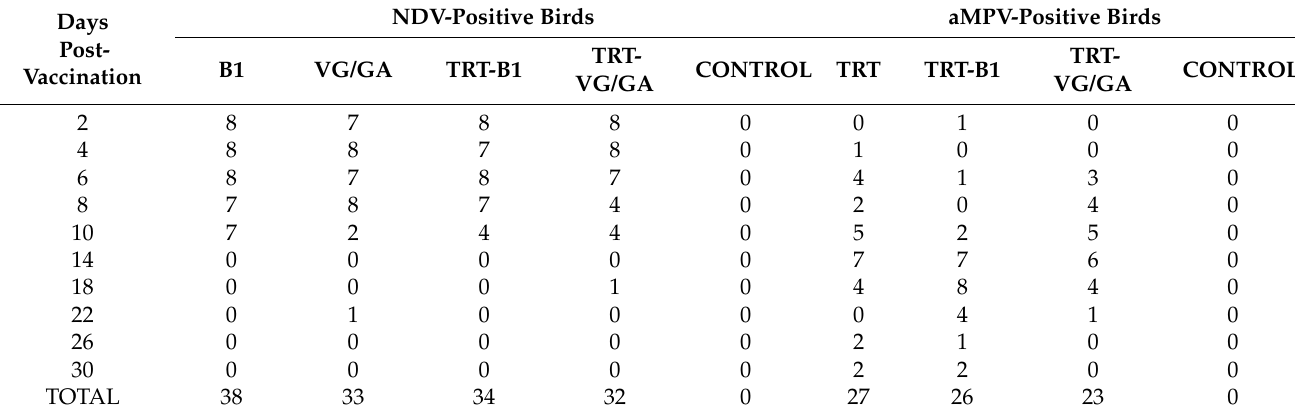
Table 2. The number of NDV and aMPV-positive birds based on the results of real-time RT-PCRs. Eight swabs were tested at each time